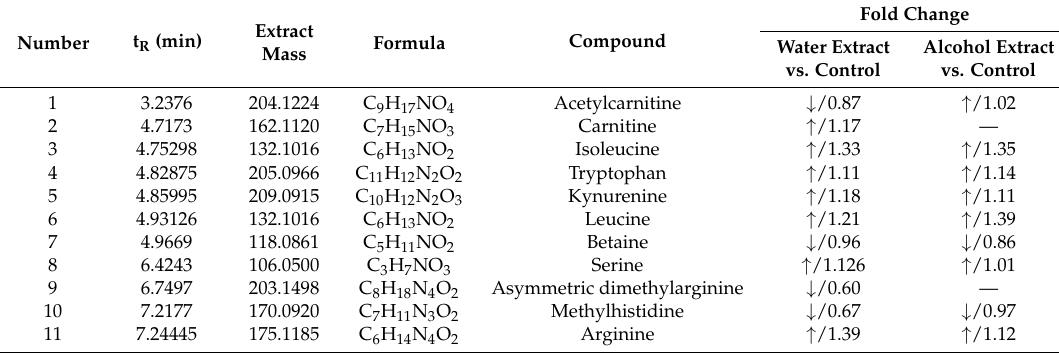
Table 1. Significantly altered metabolites in the serum samples of control, water extract, and ethanol extract rats ( n = 8).